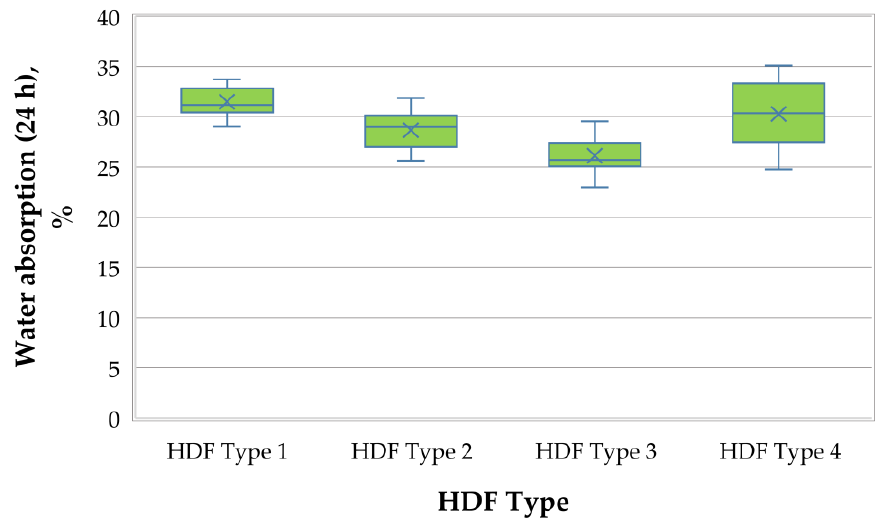
Figure 2. Water absorption (24 h) of HDF panels produced.